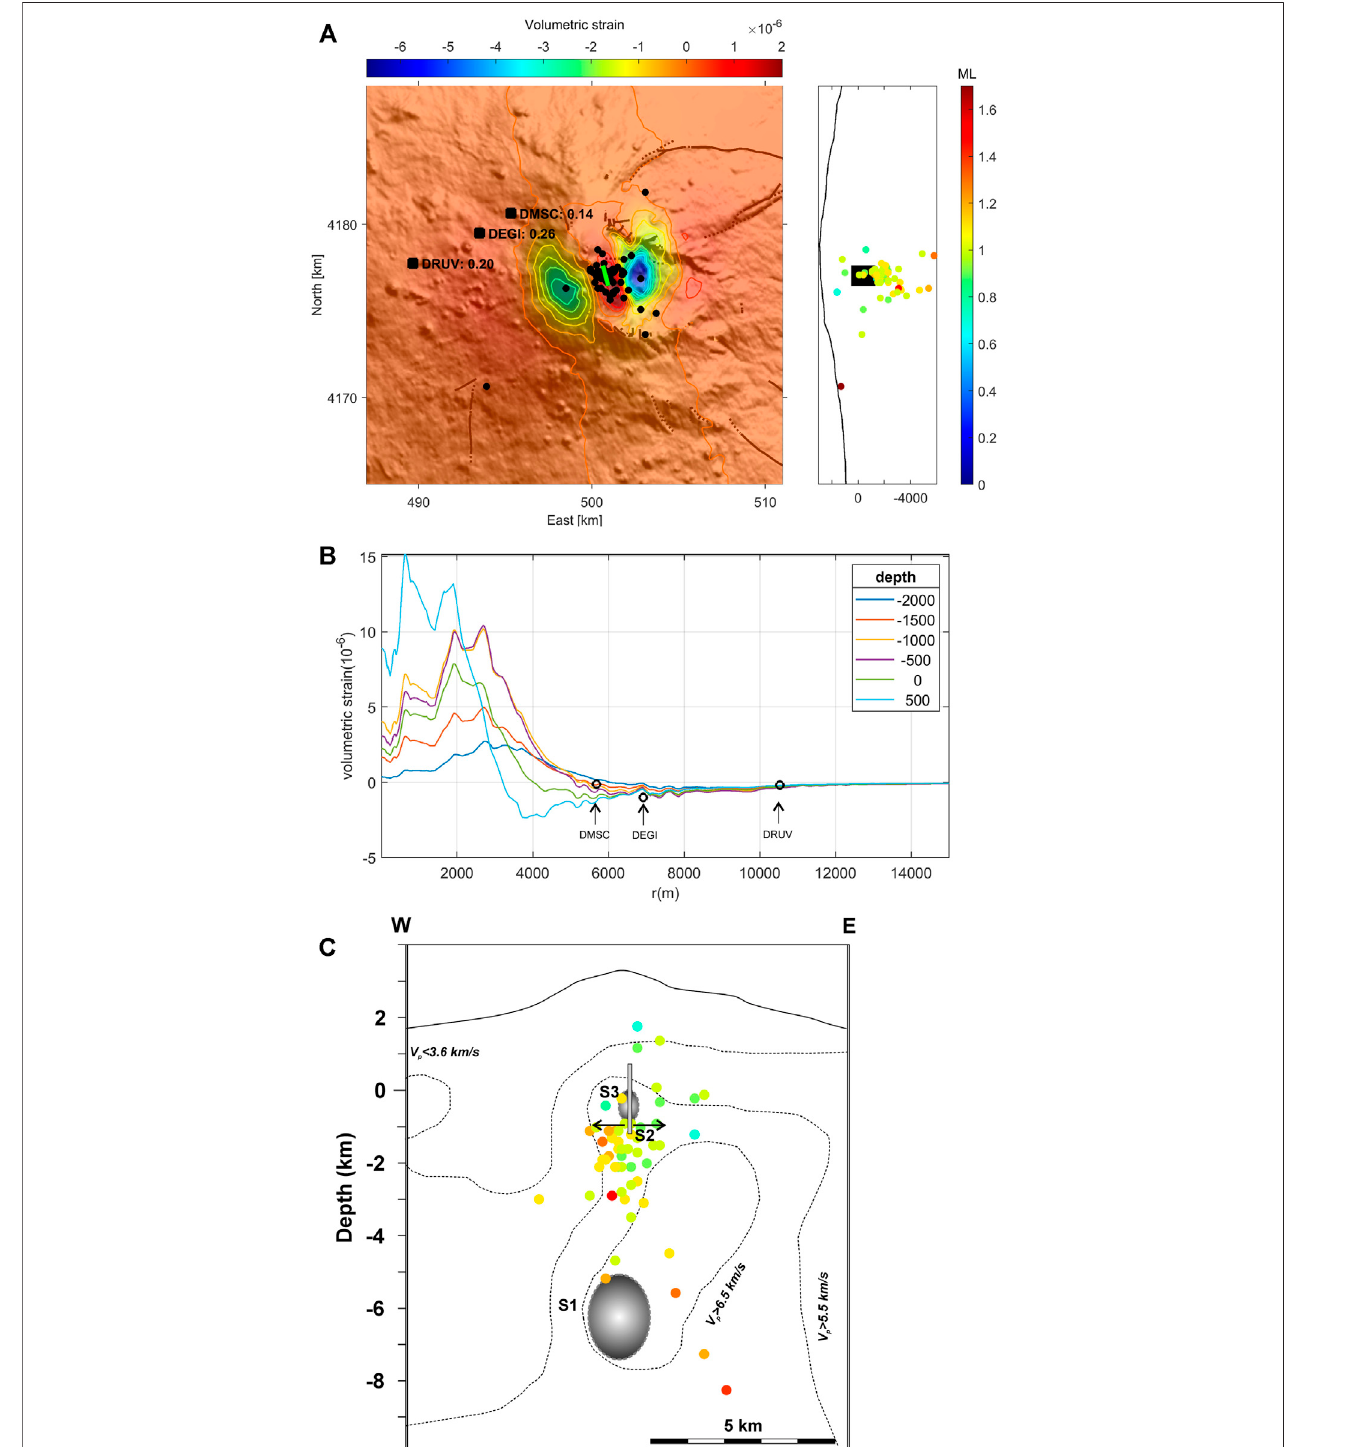
FIGURE3|(A) EtnamapwiththestrainexpectedbythetensilesourcemodelfortheDec19,2020intrusion.Thecirclesarethelocationsoftheearthquakesofthe seismic swarm. On the right, the N-S section indicating the local magnitude M L of the seismic events. (B) FE modelled volumetric strain changes (colored lines) of the prolate source, having aspect ratio 0.5 and volume change 2 × 10 6 m 3 , for different depths along a pro fi le running westward from the summit crater area. Volumetric strain changes observed at the dilatometer stations are also reported (black circles). (C) W-E section of Etna and different sources. S1 is the classic intermediate storage (Z ∼ 6 ± 2 km) modeled several times during the prolonged recharging periods over the last 40 years (i.e. Aloisi et al., 2018; Bonaccorso and Aloisi, 2021). S2 is the tensile source acting on Dec 19, 2020. S3 is the source that constrains the decompression source during the events of the lava fountain sequence. It is in the same position already modeled with the strain for the previous fountains of 2011 – 2013.